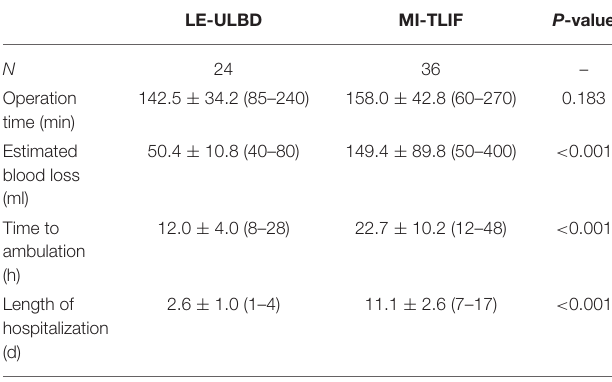
TABLE 2 | Operation characteristics of the two groups.